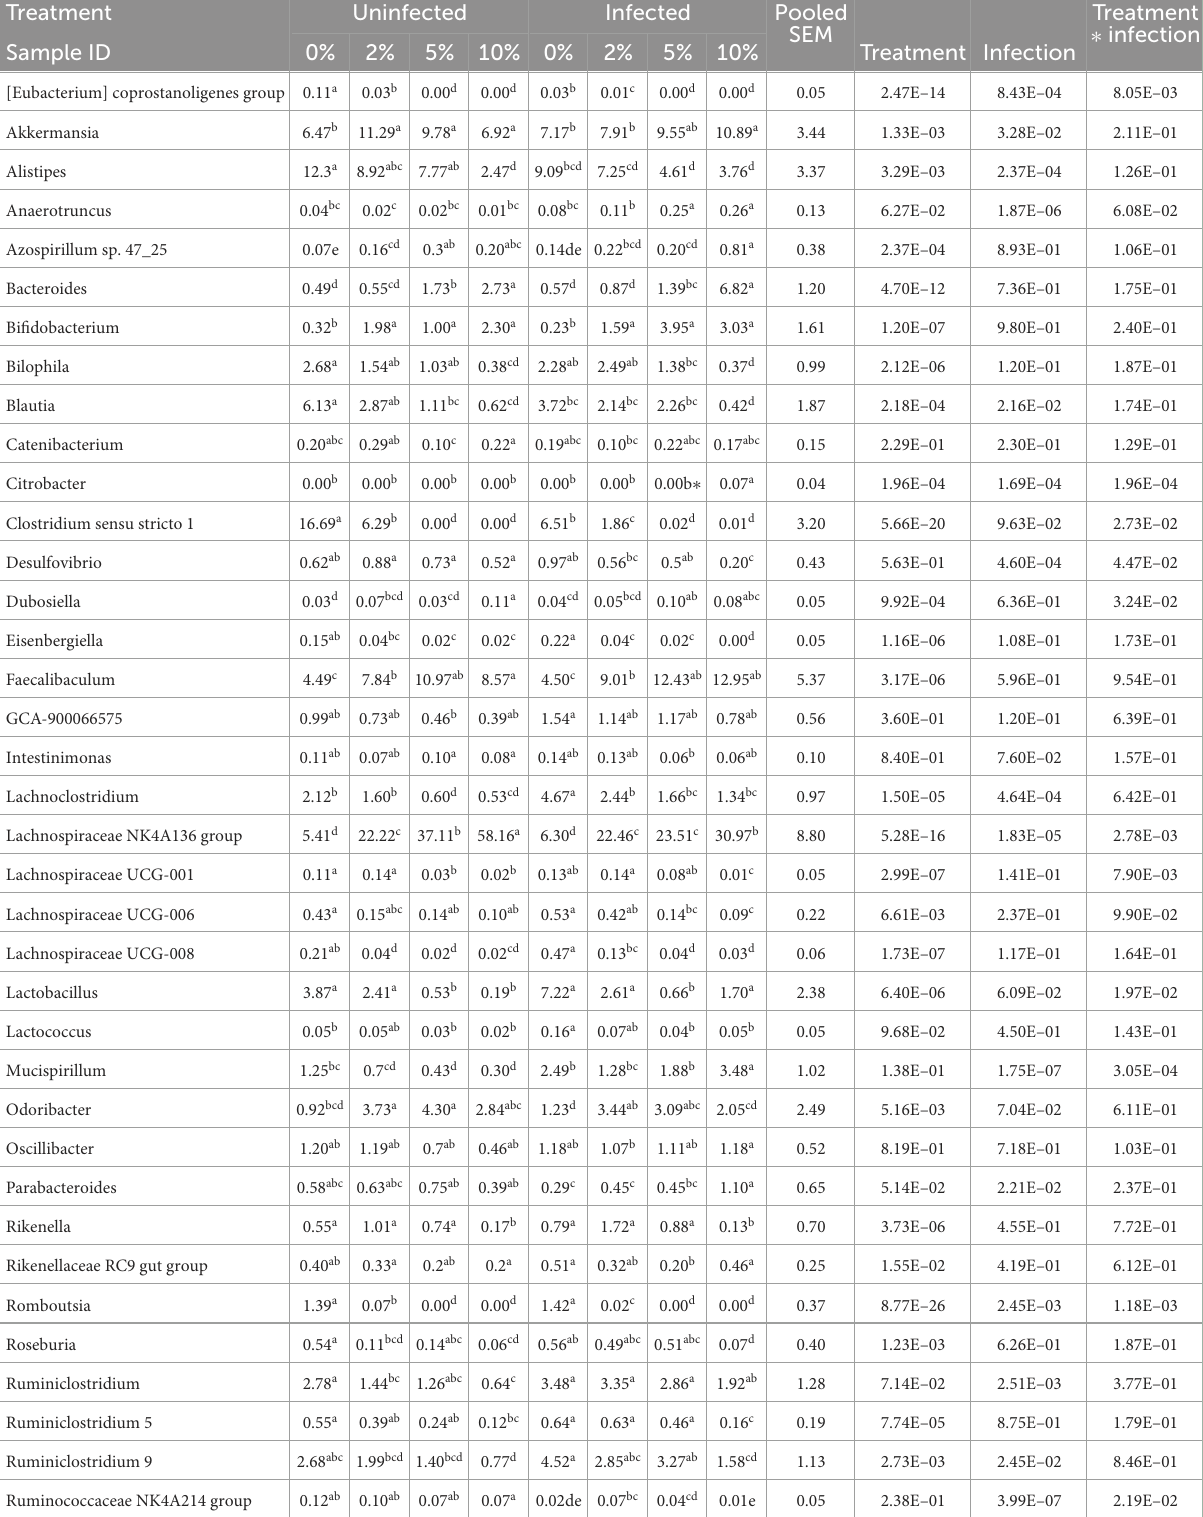
TABLE 1 Effect of diet and C. rodentium infection on various genera with relative abundance above 0.1% in cecal contents from uninfected and infected mice obtained at day 12 days post-infection 1 . Treatment Uninfected Infected Pooled